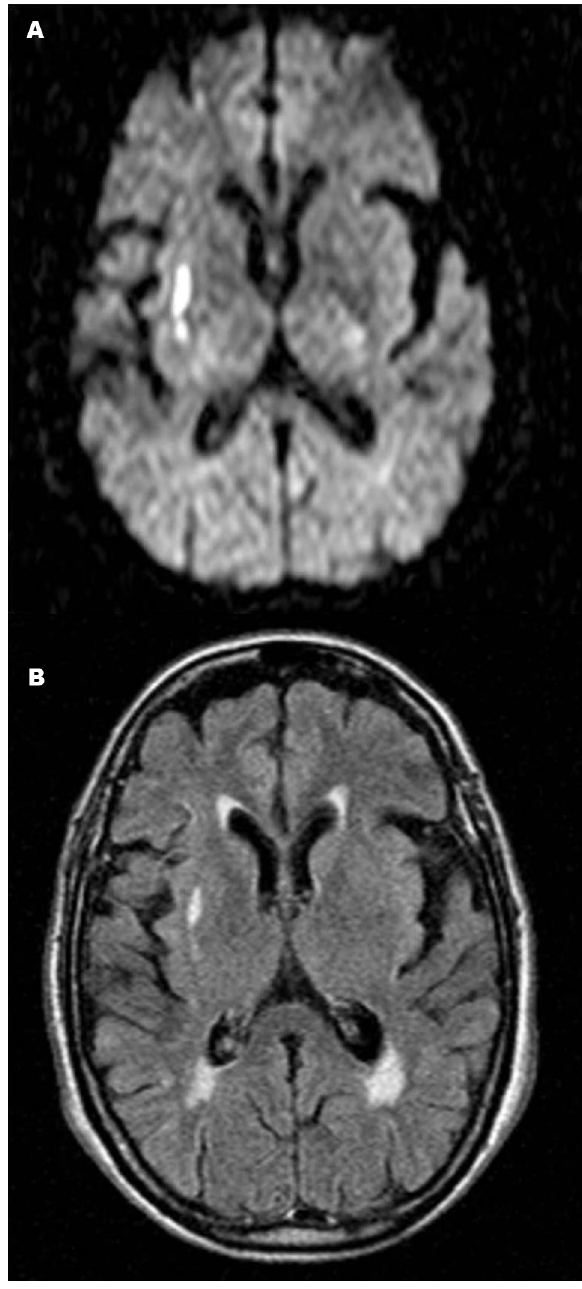
Figure 2. Axial diffusion-weighted magnetic resonance image [A] and [B]; FLAIR MRI [B] demonstrating high signal intensity in the right subcortical insular